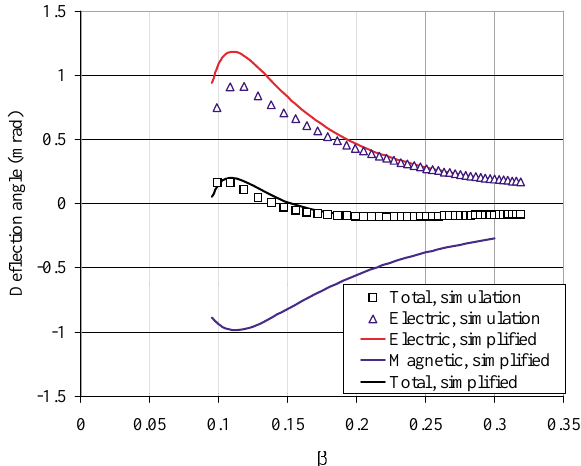
FIG. 12. (Color) Transverse emittance growth in the section of driver linac containing 42 cavities of 115 MHz QWR with and without the compensation of beam-steering